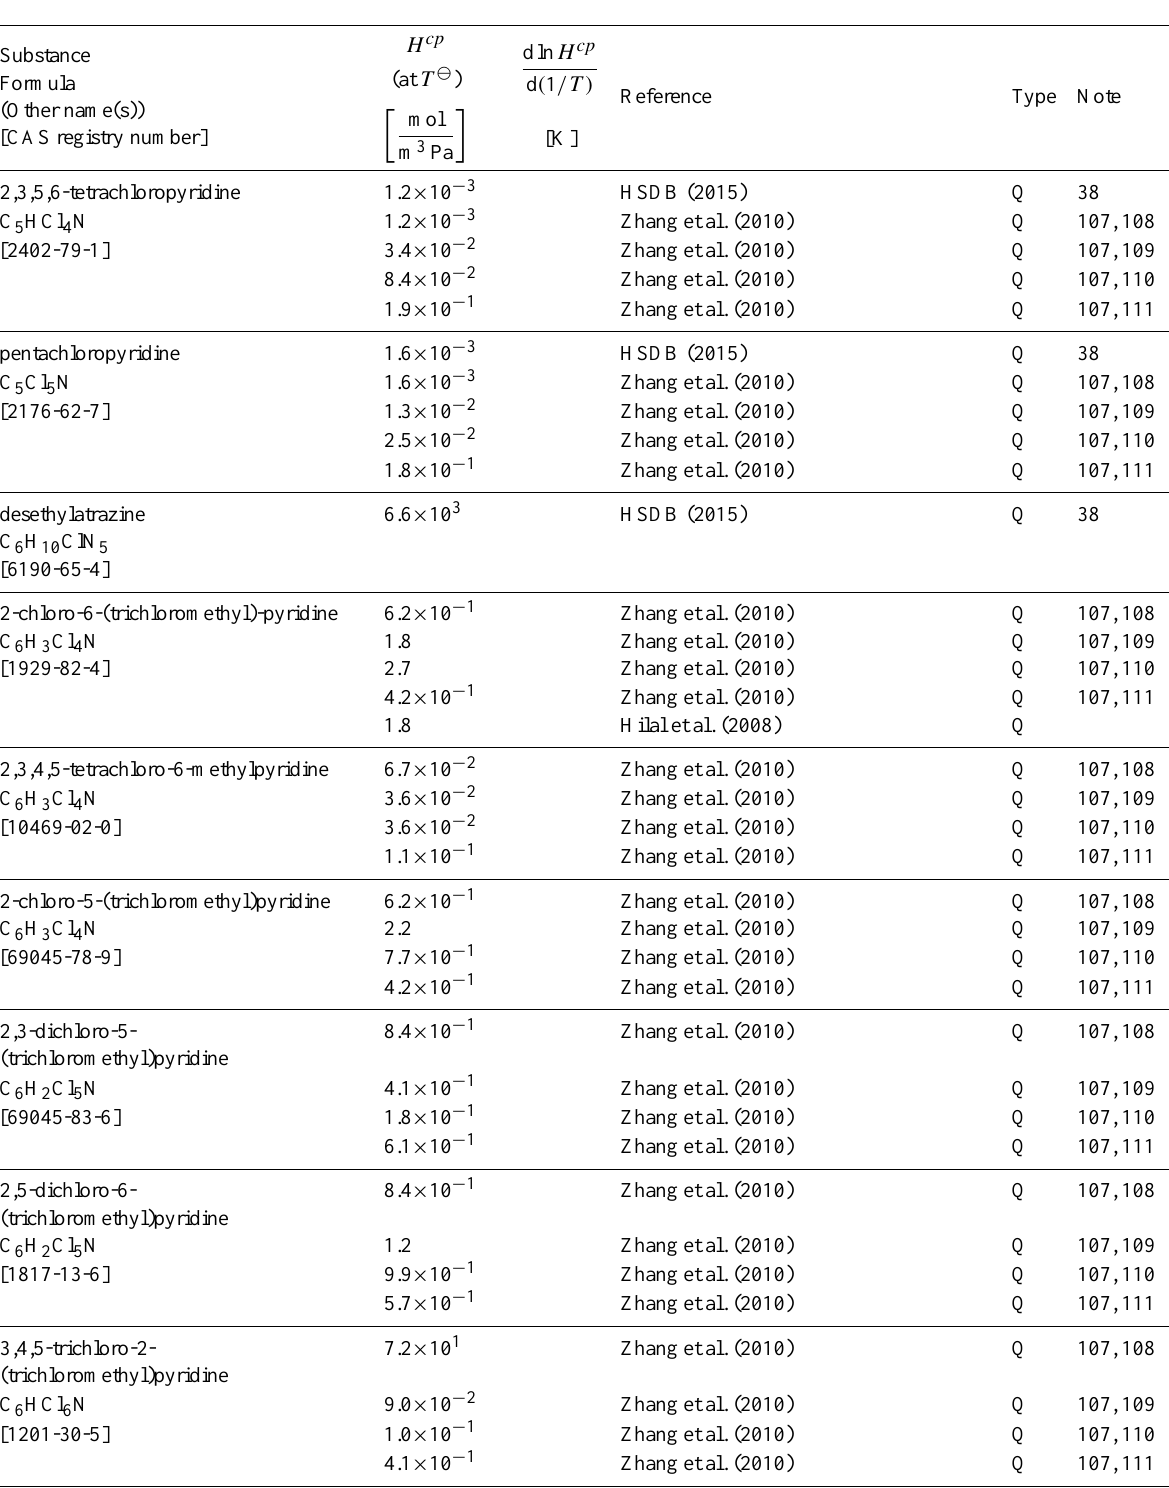
Table 6: Henry’s law constants for water as solvent